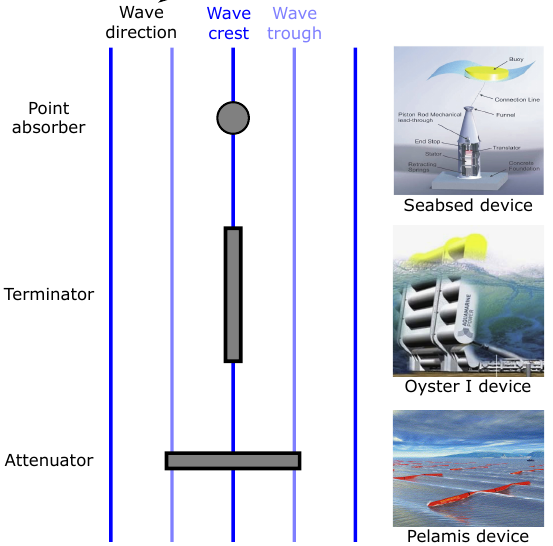
Figure 1. According to the geometries and orientations of wave energy converters, WECs can be classified as point absorbers, terminators and attenuators, with the Seabased device [58], the Oyster I device [59] and the Pelamis device [60] as typical